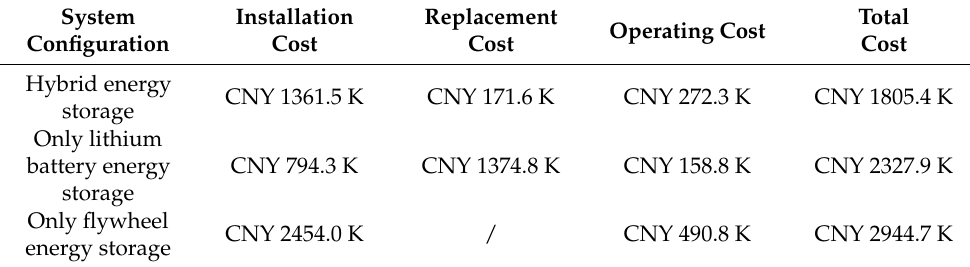
Table 6. Optimization